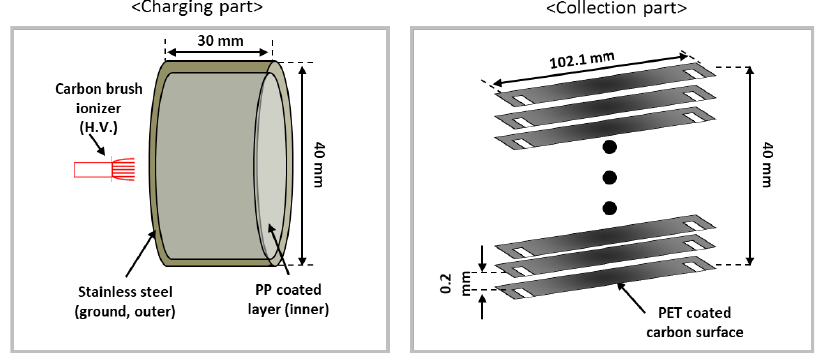
Figure 2. Schematic of the two-stage ESP. Detailed view of the charging part (left) and collection part with electrothermal carbon plates